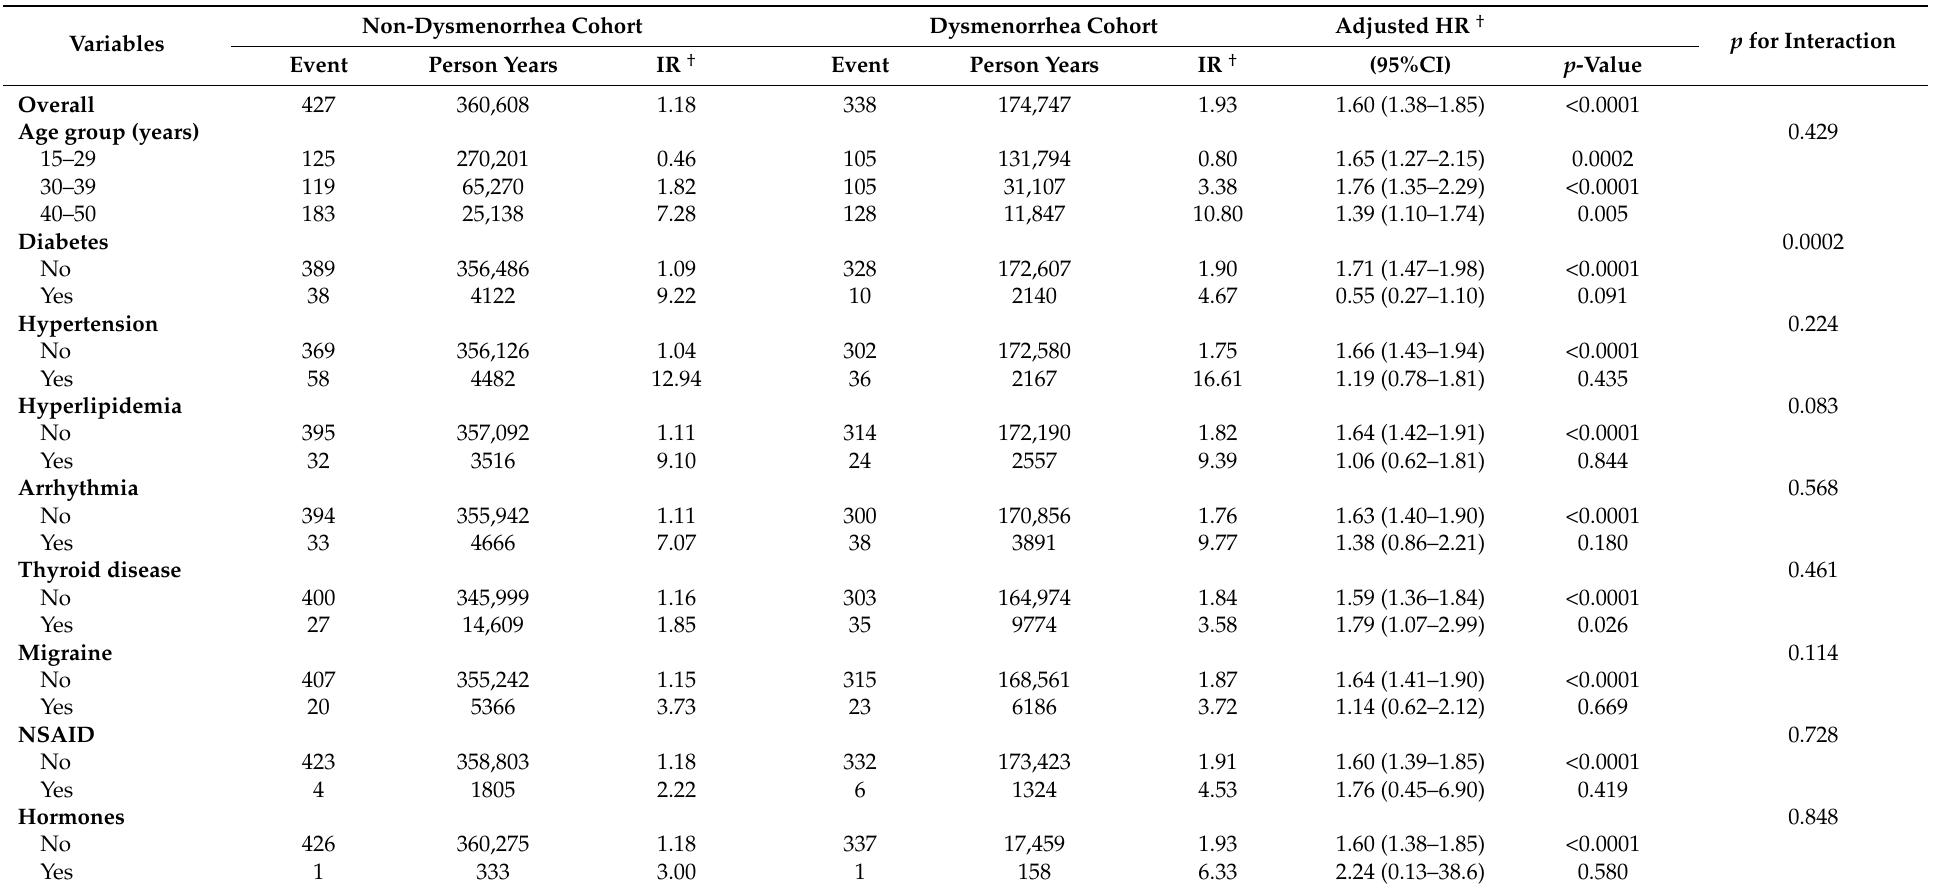
Table 2. Incidence of ischemic heart disease and primary dysmenorrhea cohort to non-dysmenorrhea cohort hazard ratio by age, comorbidity, and medicine